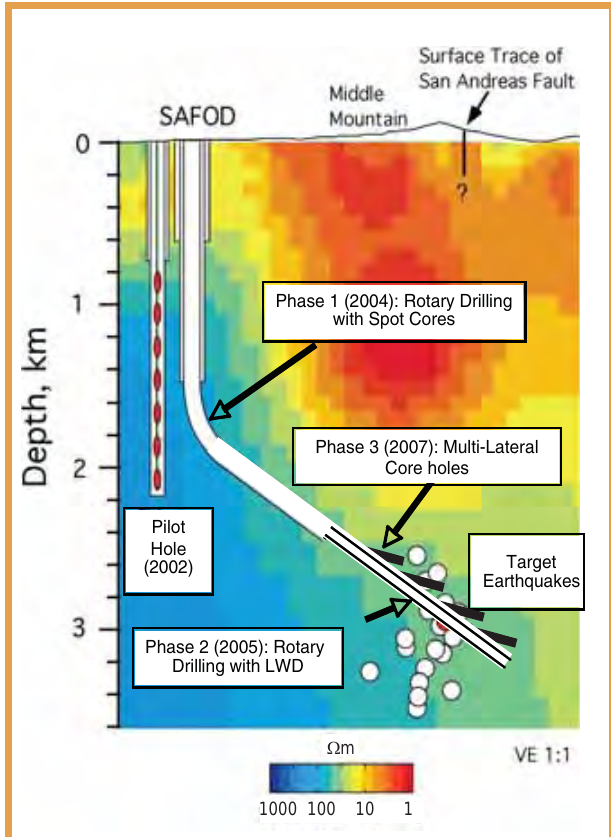
Figure 2. Schematic of SAFOD drilling program superimposed on electrical resistivity structure (after Unsworth and Bedrosian, 2004). The exact locations of the four multi-lateral core holes to be drilled in 2007 will be determined from analysis of data obtained during Phases 1 and